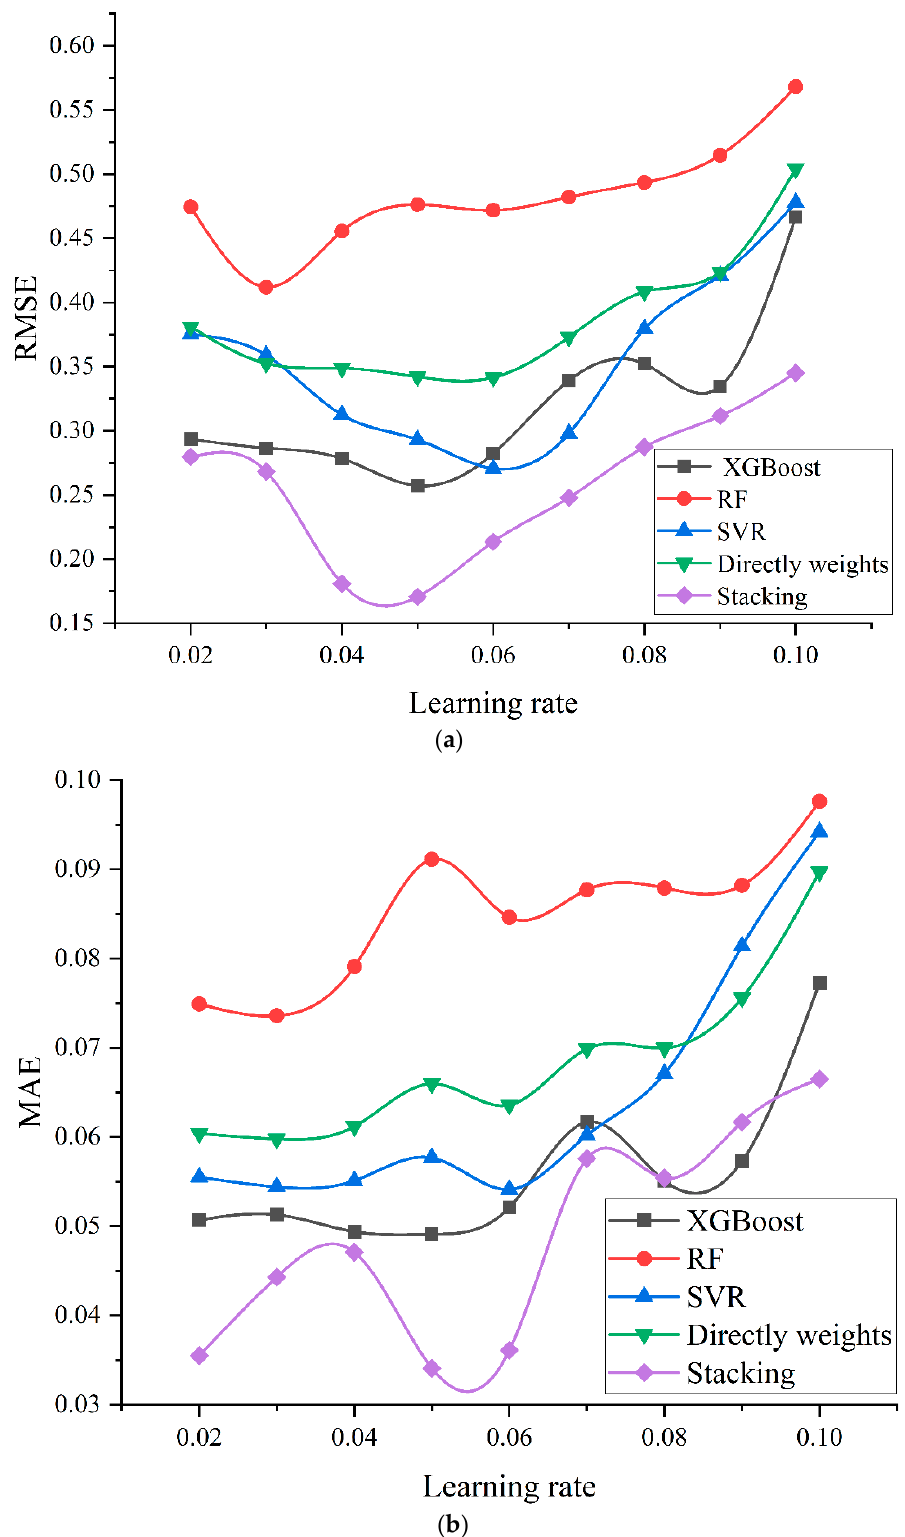
Figure 2. ( a ) Root-mean-square error of each model under different learning rates; ( b ) average ab-